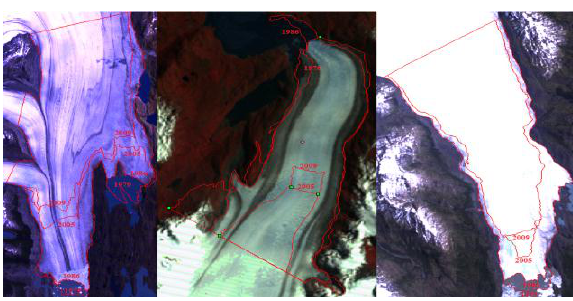
Figure 2. Linhas de variação na posição da língua das Geleiras Upsala, Jorge Montt e Tyndall. Geradas a partir